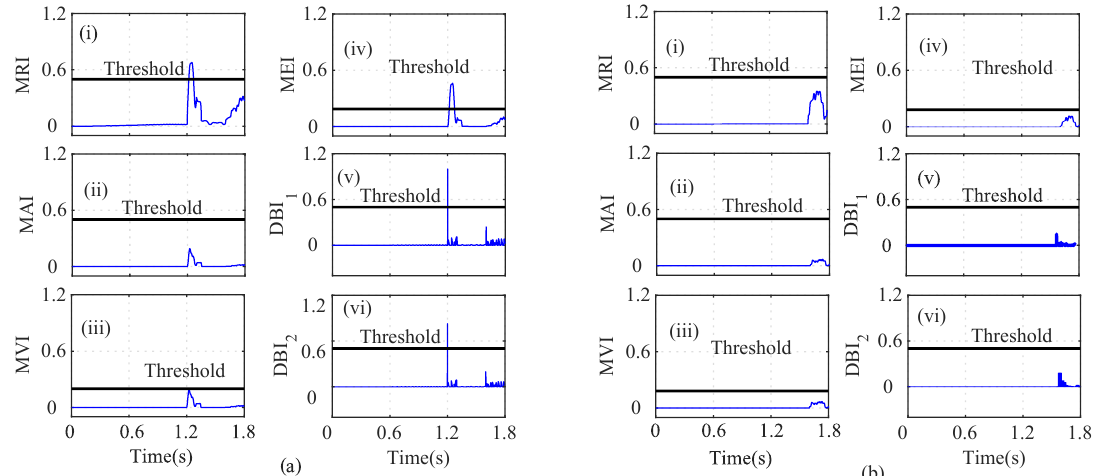
Figure 8. Analysis of residuals for ( a ) I α and ( b ) I β using index-based methods ((i) MRI, (ii) MAI, (iii) MVI, (iv) MEI, (v) DBI 1 and (vi) DBI 2 ) during the incipient i α fault and abrupt V β fault scenario at t = 1.256 s and t = 1.60 s, respectively.